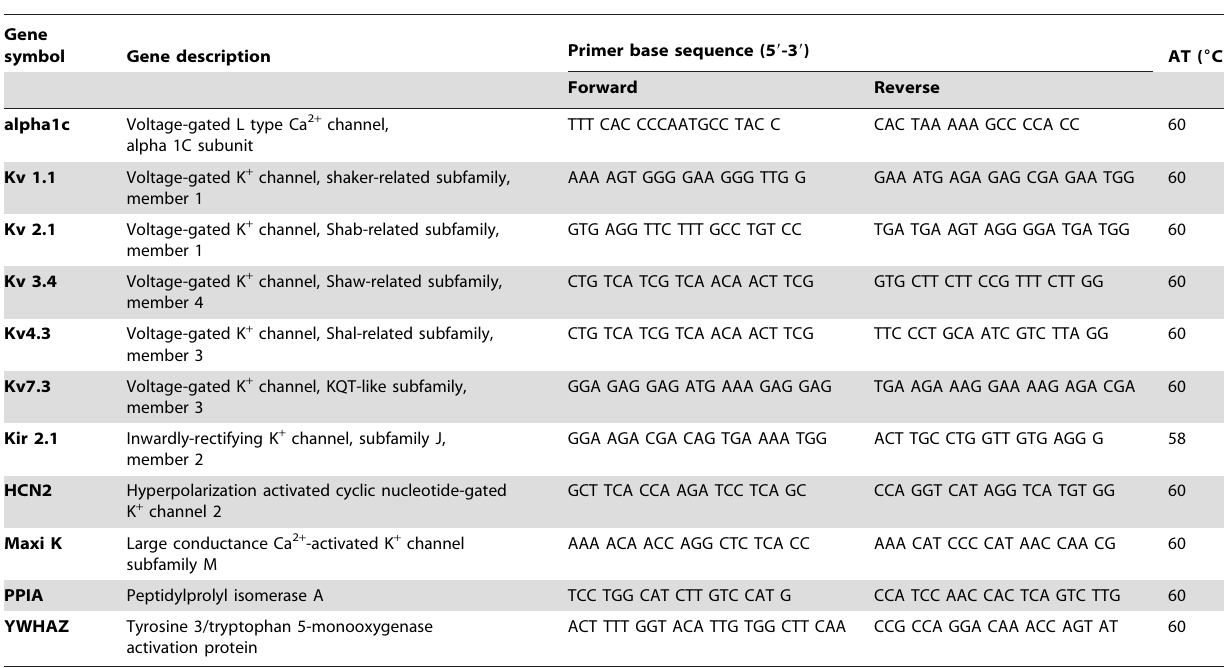
Table 1. List of genes, primer sequences, and annealing temperatures (AT) used in this study.